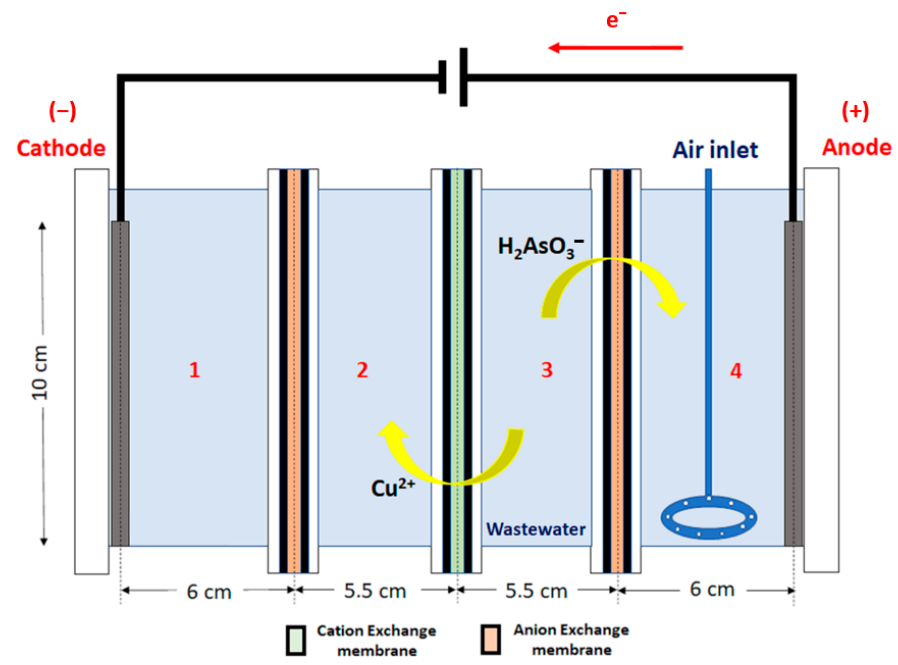
Figure 1. The experimental cell